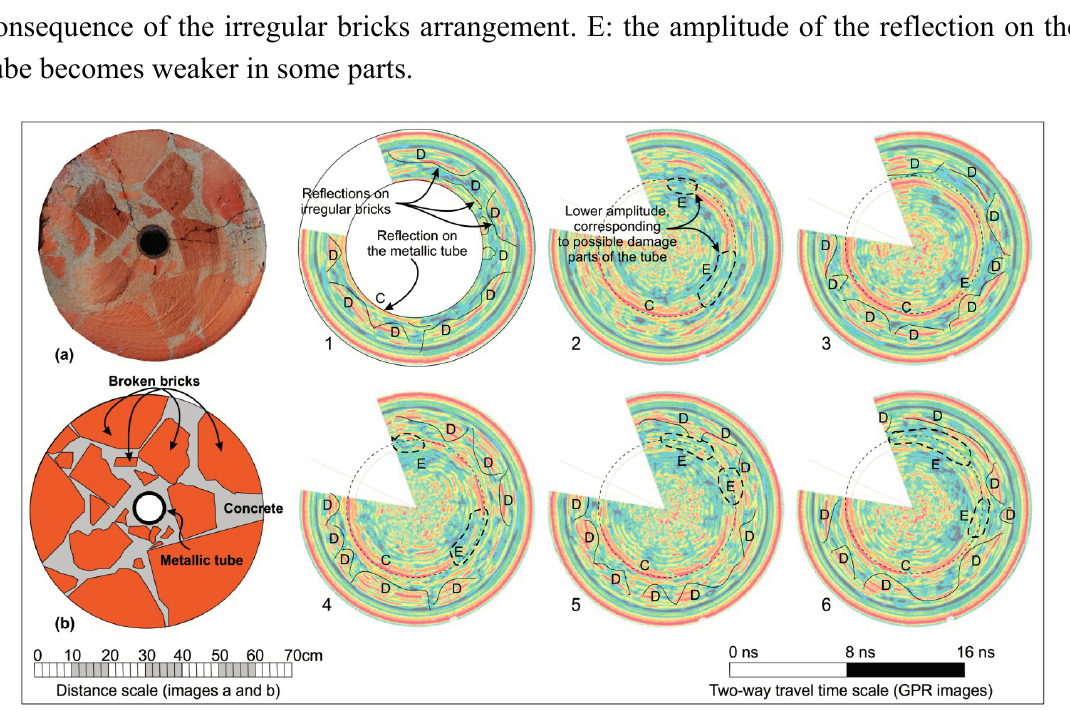
Figure 7. Section of the column ( a ); photograph of one section; ( b ) schematic drawing, showing the different inner elements and possible interpretation of the circular profiles (1 to 6). C: anomaly caused by the internal metallic tube. D: irregular pattern as